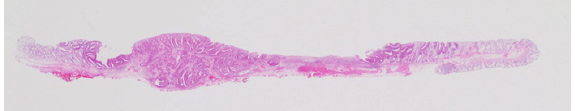
Figure 5: Histopathological analysis of the resected specimen showed a well-di ff erentiated adenocarcinoma, and the depth of invasion was sm 2500 µ m with negative lateral and vertical